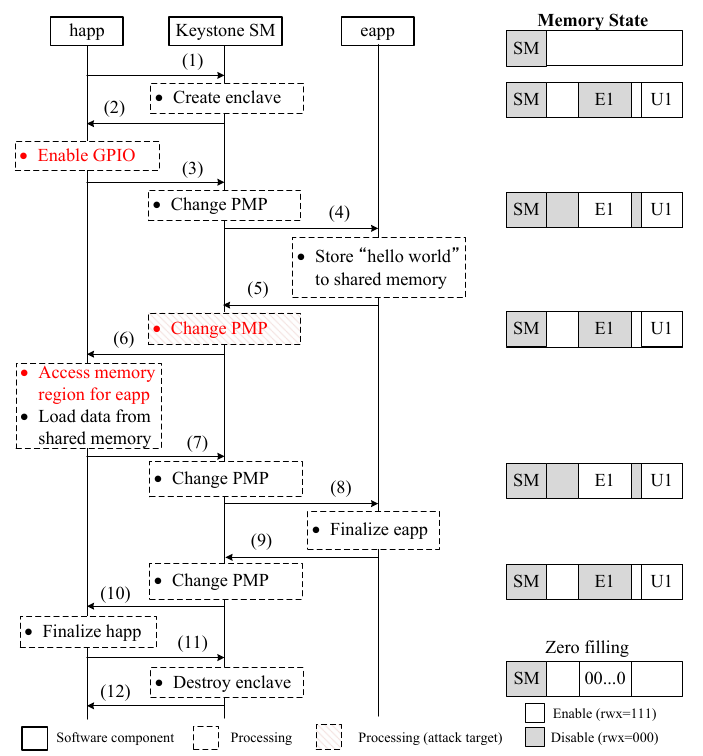
Figure 12: Sequence diagram for exploitation and memory state. Red text in the sequence diagram indicates changes from the original process. E1 and U1 in memory state represent memory for eapp and shared memory,